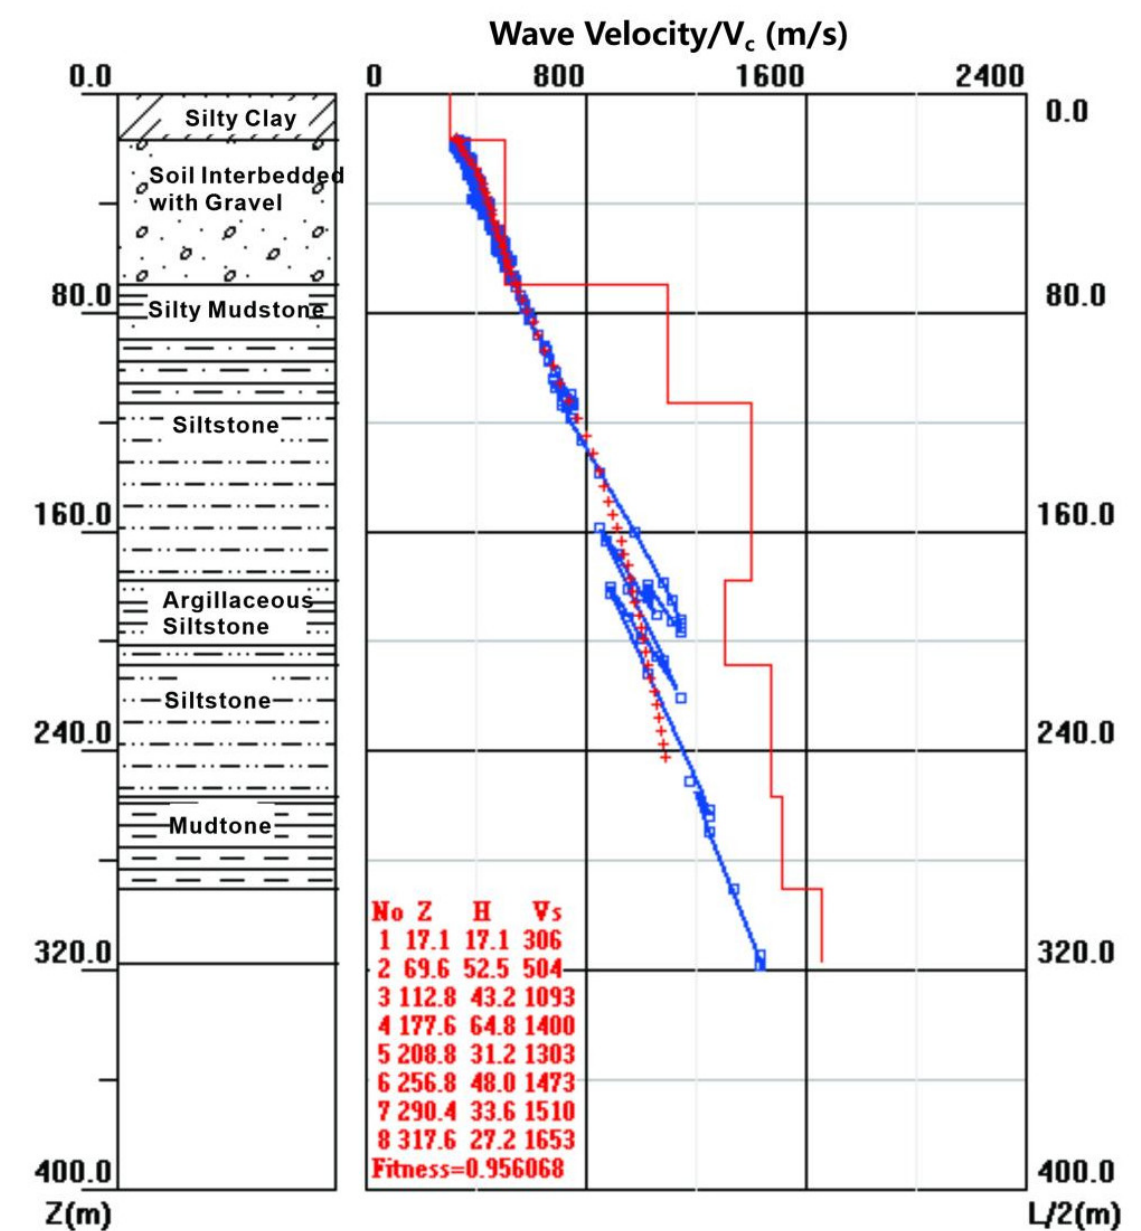
Figure 4. Lithographic layering results of sk10 natural source surface wave microtremor detection of dispersive wave velocity.